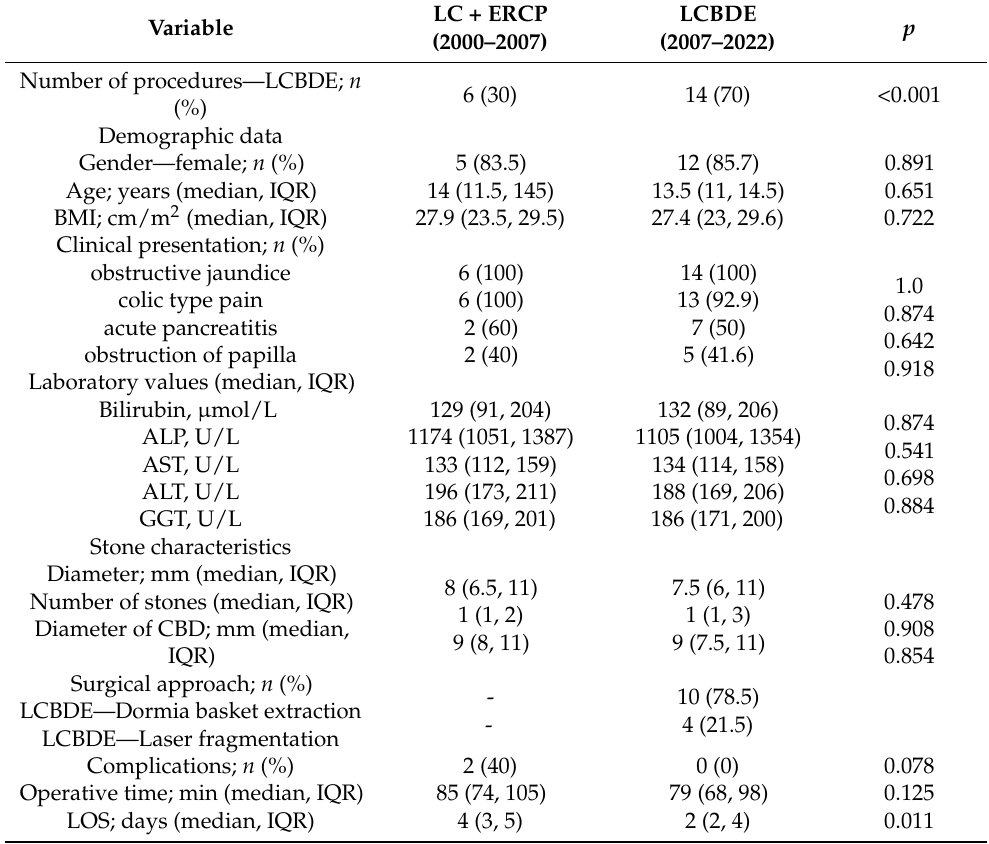
Table 2. Demographic and clinical characteristics of children who underwent